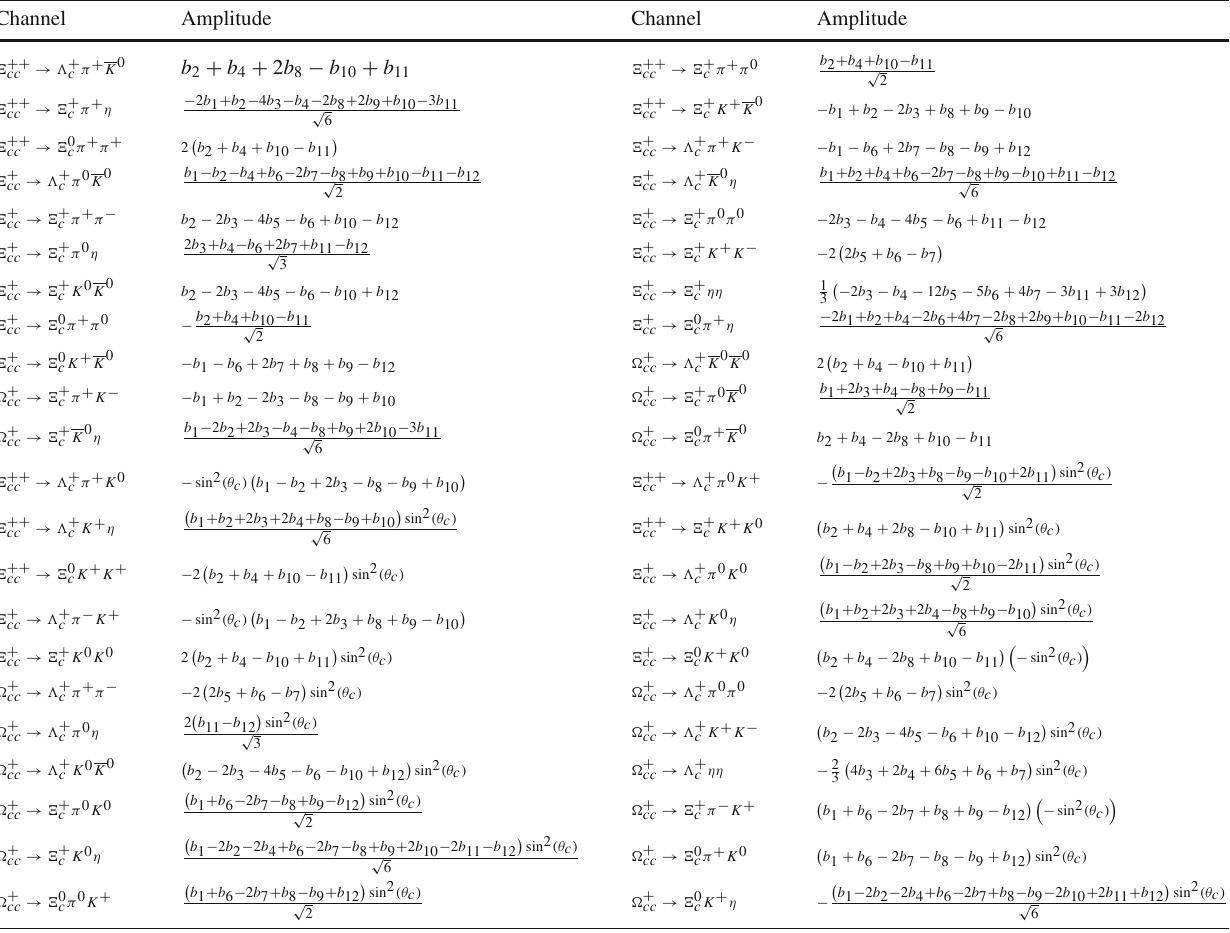
Table 6 Doubly charmed baryon decays into an anti-triplet cqq and two light mesons Channel Amplitude Channel